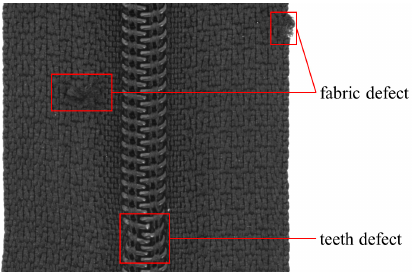
Figure 1 . An example of a defect sample with non-uniform structures. The top two boxes indicate a type of fabric defect. The bottom box indicates a type of teeth defect.